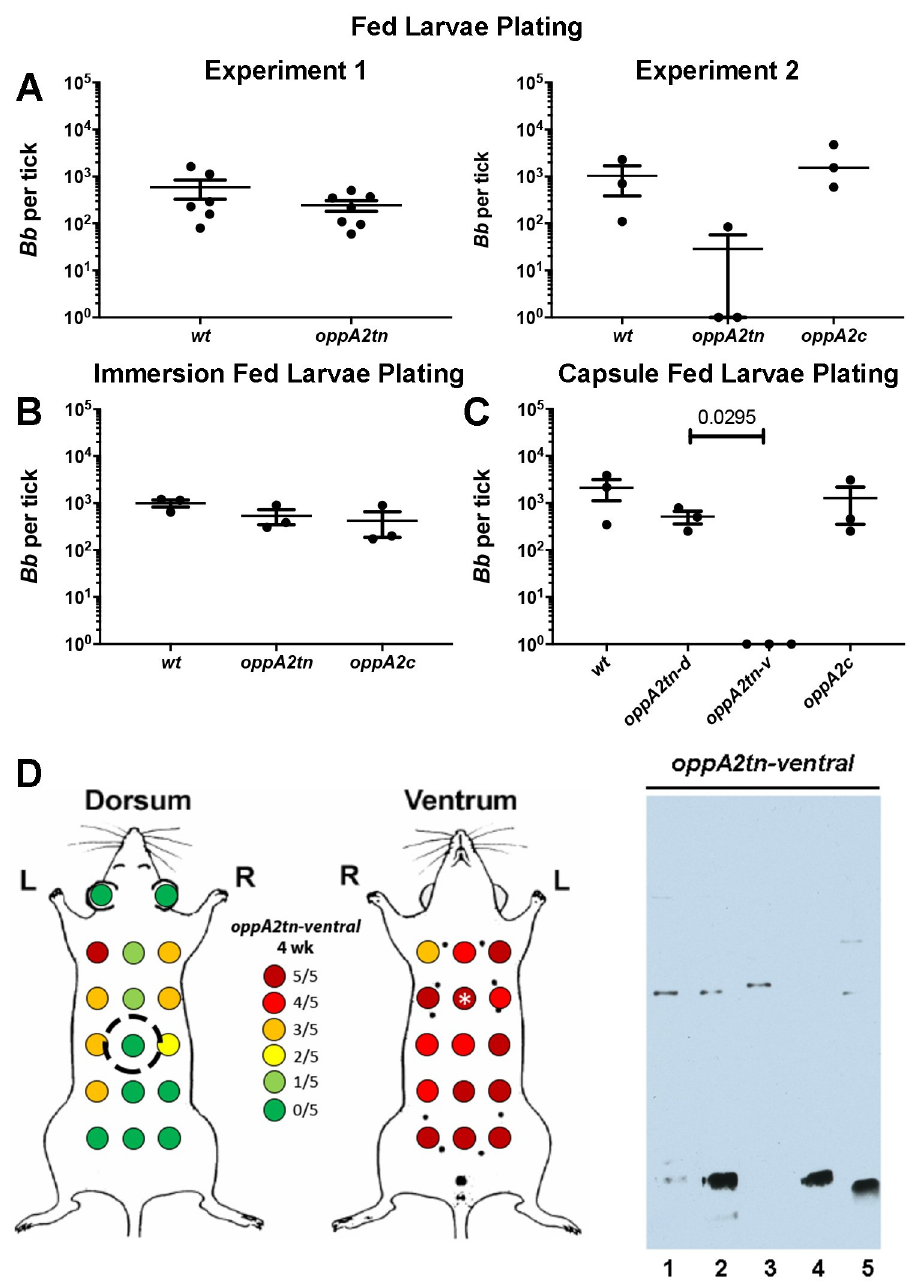
Fig 5. oppA2 is dispensable during larval acquisition. (A) Two preliminary experiments measuring spirochete burdens (mean ± SEM) assessed by colony counts in midguts from larvae naturally fed on mice infected with wt , oppA2tn , or oppA2c . (B) Colony counts (mean ± SEM) from midguts of larvae immersion fed with wt , oppA2tn , or oppA2c cultures and subsequently fed on na ï ve C3H/HeJ. (C) Colony counts (mean ± SEM) from midguts of larvae naturally fed on mice infected with wt-dorsally , oppA2tn-dorsally , oppA2tn-ventrally , or oppA2c-dorsally . (D) Maps of skin sample sites and culture results and immunoblot analysis using B . burgdorferi whole cell lysates of sera from mice ventrally-infected with 1 x 10 4 oppA2tn (n = 5). Inoculation sites are designated with a white asterisk. Dotted circle denotes capsule placement for larval